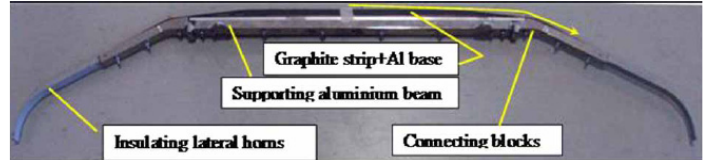
Figure 1: Italian high-speed train collector.